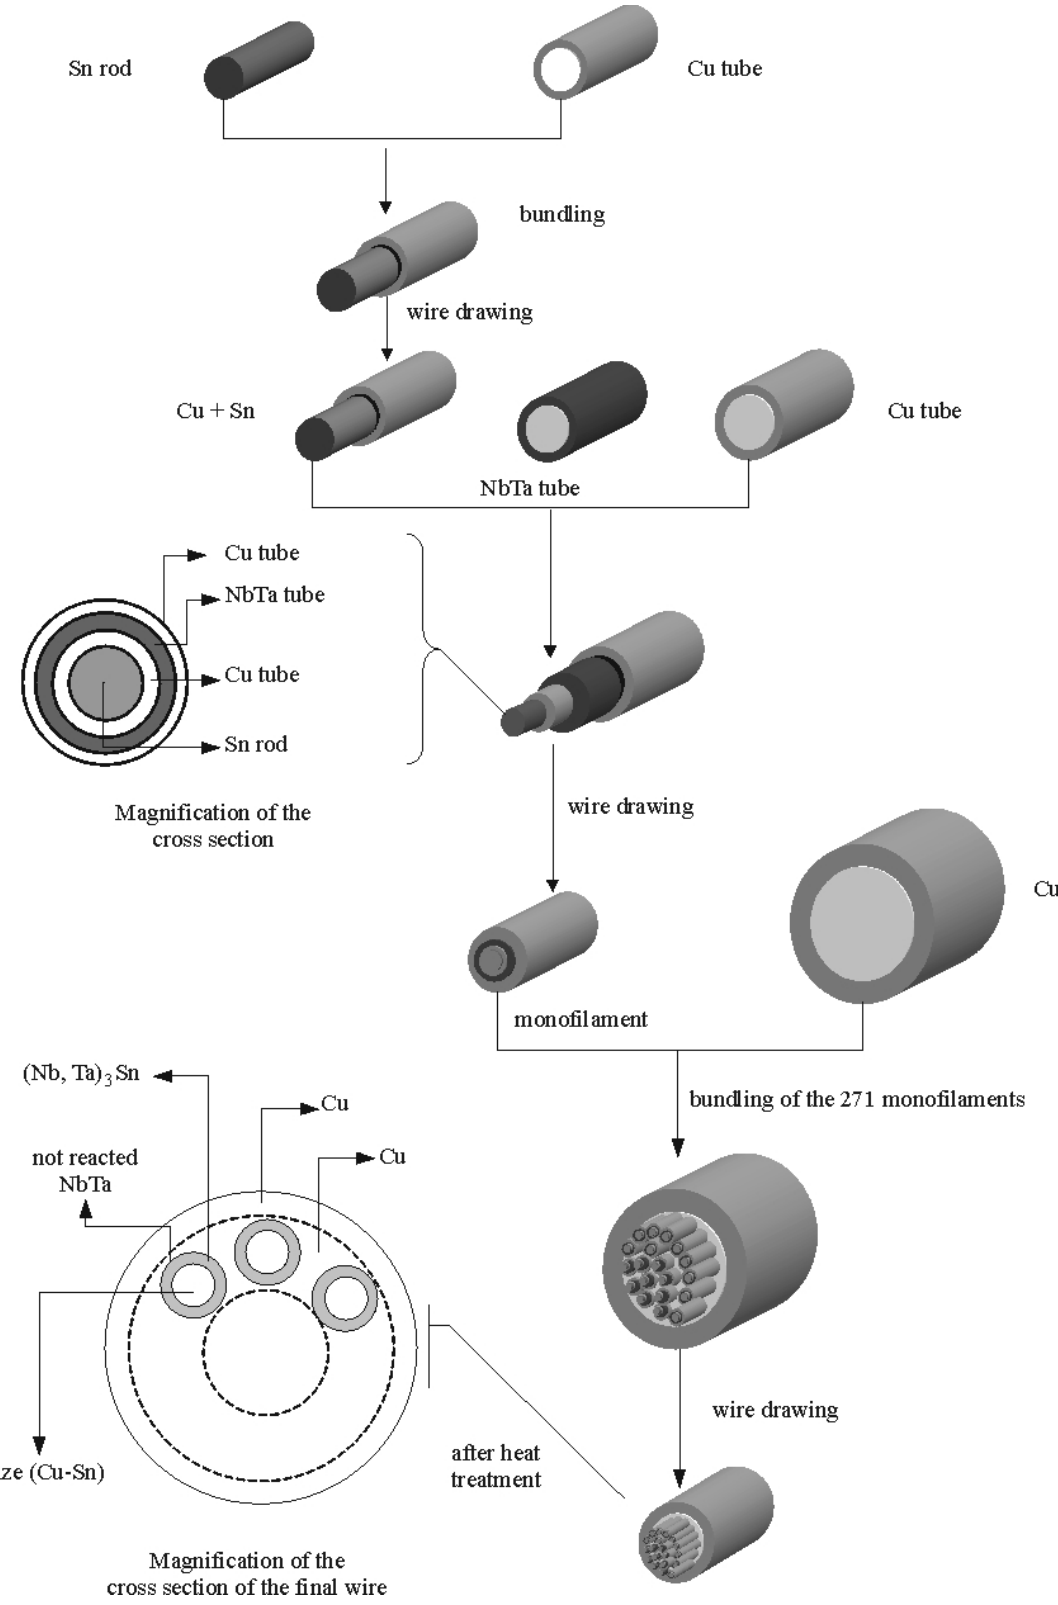
Figure 1. Fabrication route of the (Nb,Ta) 3 Sn superconductor wire using the solid-liquid diffusion method (or NbTa tube